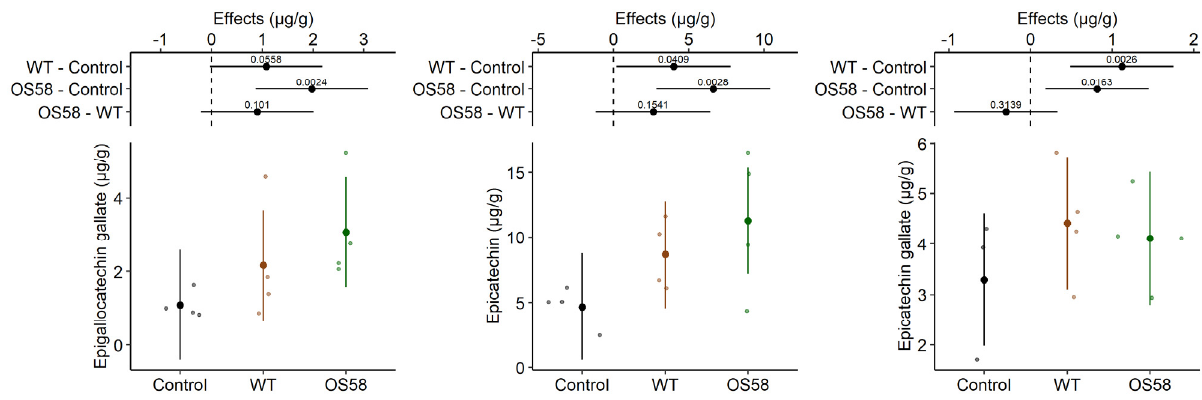
Figure 3. The catechins content (calculated as μ g per gram of fresh cauliflowers) is reported for the Control, WT, and OS58 groups. A detailed description of these types of plots is provided in Figure 2.